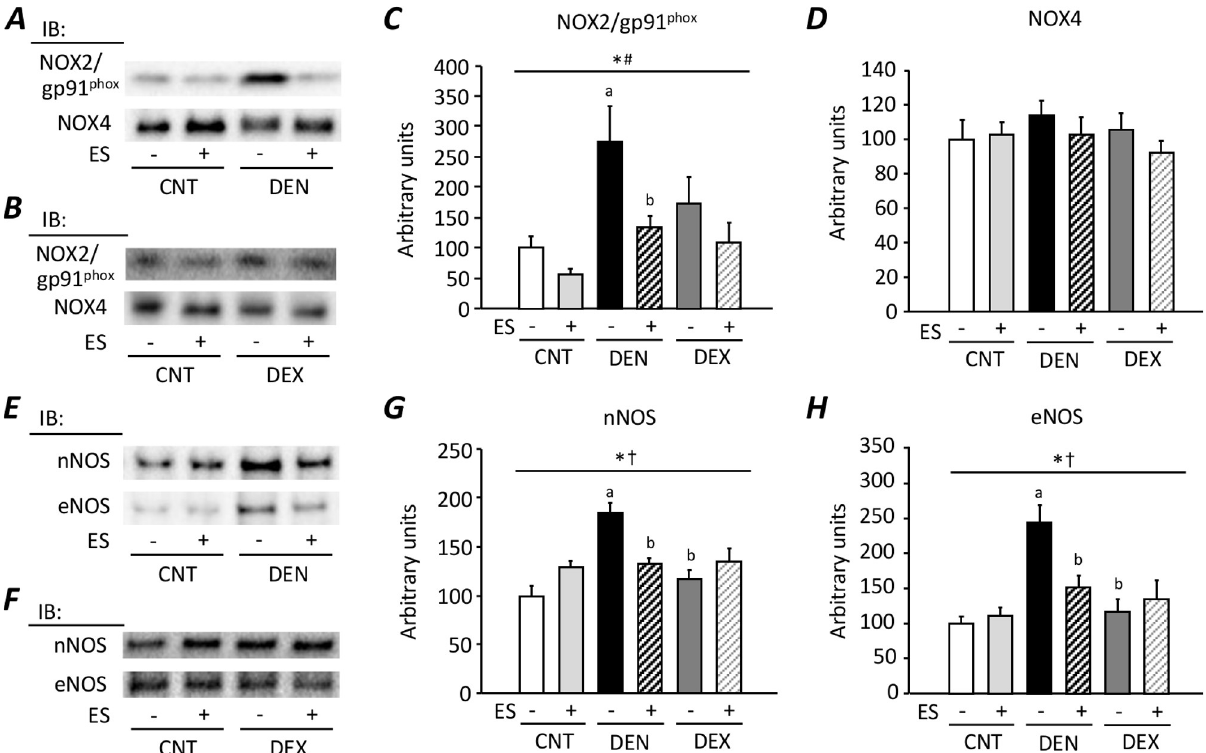
Fig 4. Neuromuscular electrical stimulation (ES) training prevents the upregulation of ROS/RNS producing proteins in DEN muscles. Representative immunoblots illustrating the levels of NADPH oxidase (NOX2/gp91 phox ), NOX4 ( A, B ), neuronal nitric oxide synthase (nNOS), and endotherial NOS (eNOS) ( E, F ) in whole muscle protein of gastrocnemius muscles from control (CNT), denervation (DEN), and dexamethasone (DEX) rats with or without ES training. The levels of NOX2/gp91 phox ( C ), NOX4 ( D ), nNOS ( G ), and eNOS ( H ) expression were normalized to the total protein content seen in the stain free images. Bars show the mean and SEM results from 5–9 muscles per group. Statistical significance was set at P < 0.05: main effect of � treatment (i.e., DEN and DEX) and # ES; † interaction of treatment and ES; difference versus a CNT and b DEN.